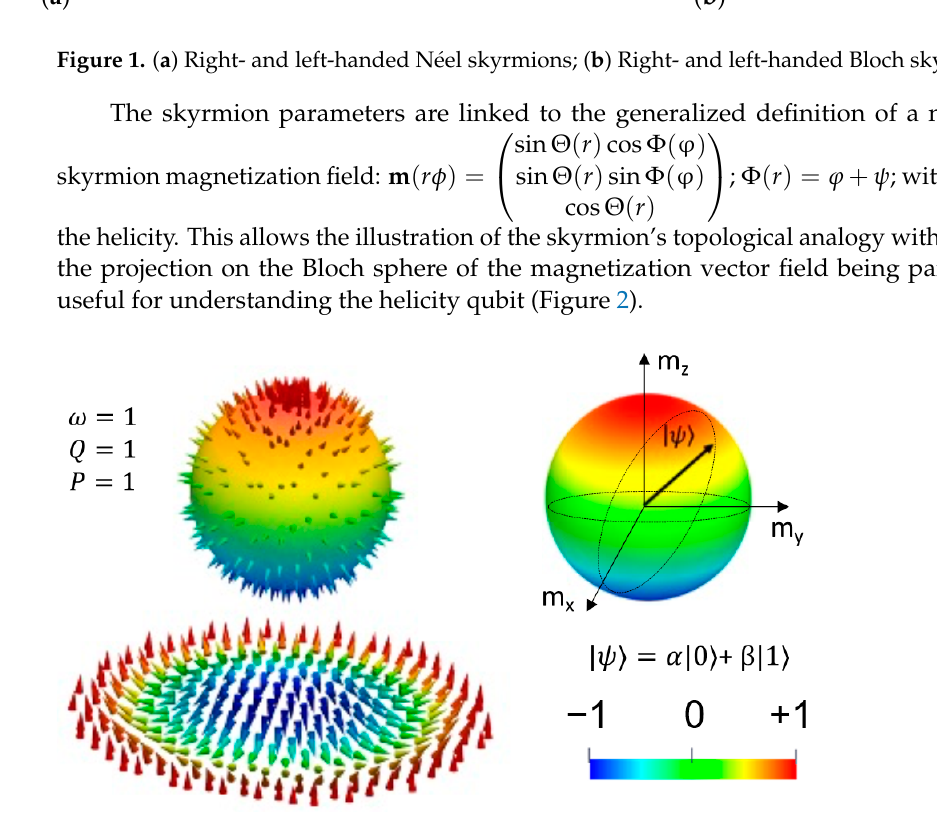
Figure 2. Left: Hedgehog representation of a Néel skyrmion magnetization vector field projected on the Bloch sphere. We indicated the vorticity ω , the topological charge Q and the core polarization P. Right: Bloch sphere and the helicity qubit: encoding the quantum superposition of | 0 (cid:105) : m z = + 1 and | 0 (cid:105) : m z = − 1: | ψ (cid:105) = α | 0 (cid:105) + β | 1 (cid:105) . The representation is issued following our micromagnetic simulations, see next paragraph.